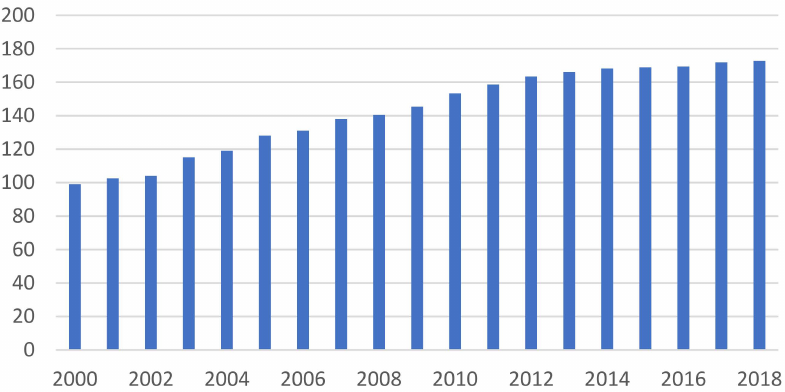
Figure 1. The rising number of rural migrants who left their rural hometown from 2000 to 2018 (million). Source: National Bureau of Statistics,